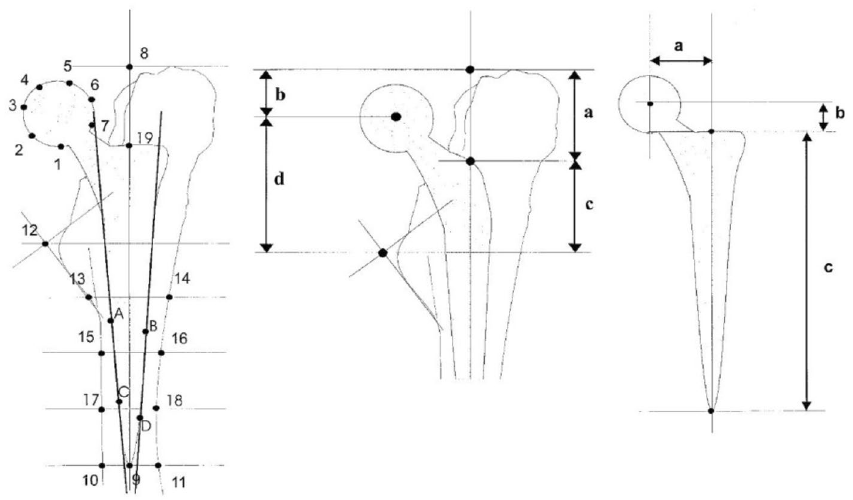
Figure 3. ( a ) Horizontal distance between the center of the prosthetic head and the shoulder point, ( b ) Vertical distance between the center of the prosthetic head and the shoulder point, ( c ) Distance between the shoulder point and the tip of the prosthesis, from R. Biedermann et al. J Bone Joint Surg Br 1999 13